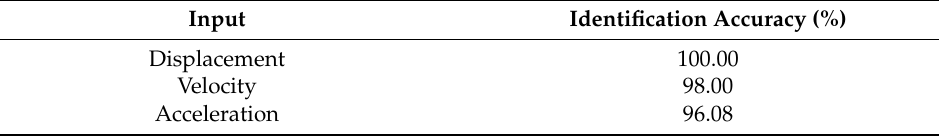
Table 3. Identification results of vehicle